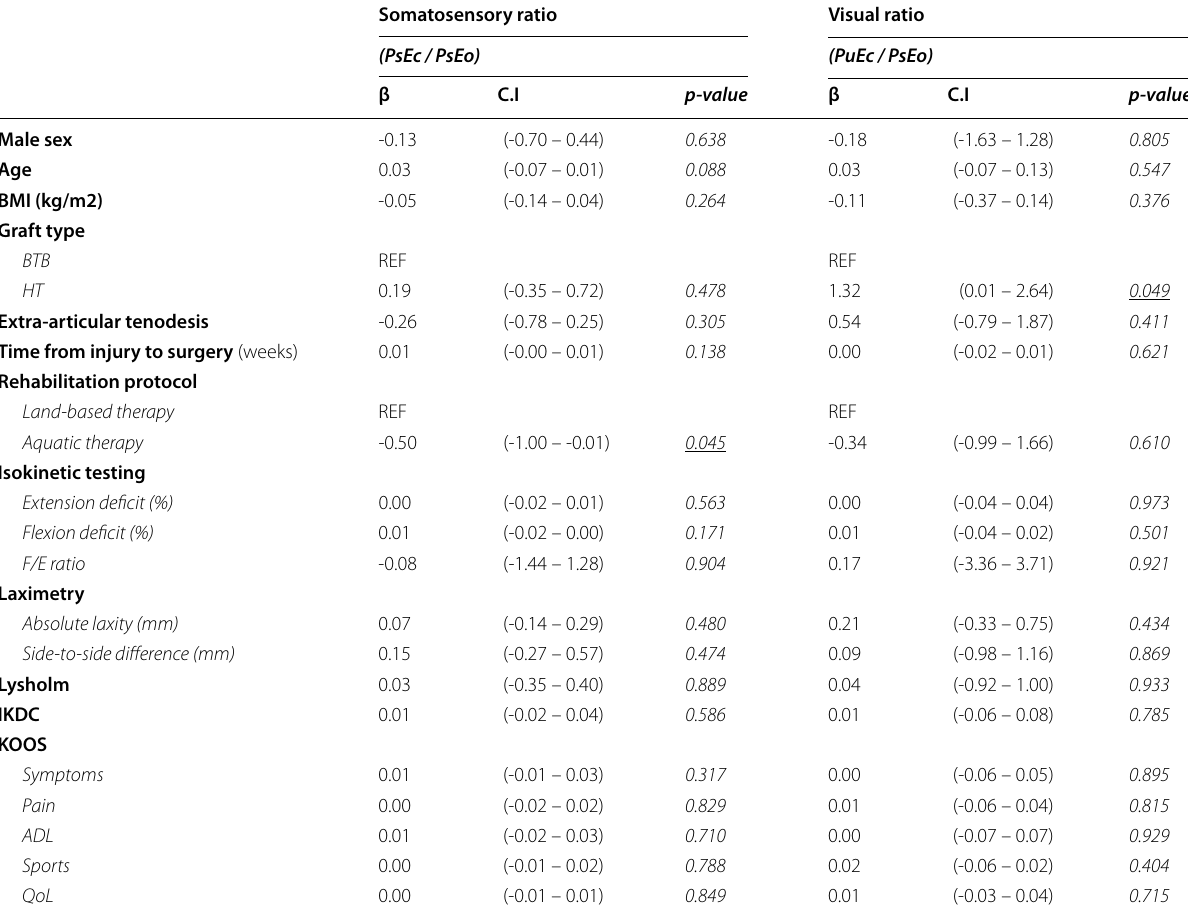
Table 3 Univariable linear regression analyses to identify factors associated with postoperative posturography measurements